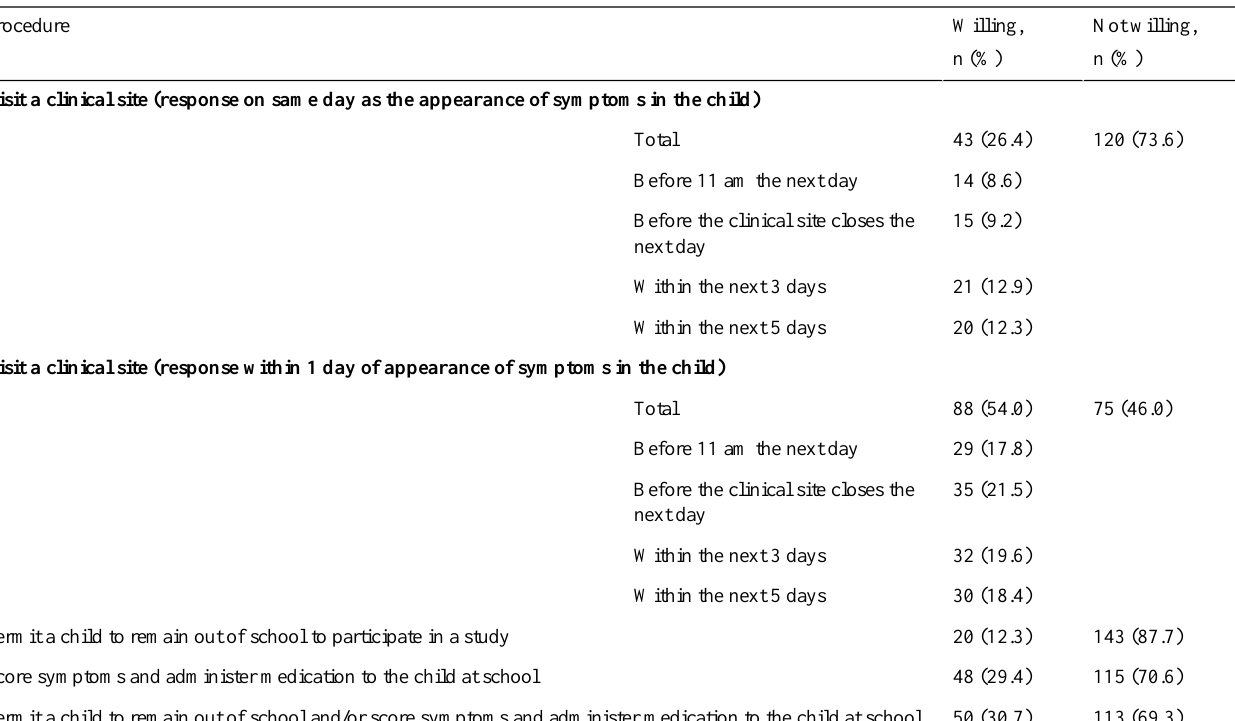
Table 2. Parent willingness to participate in clinical study procedures (N=163).